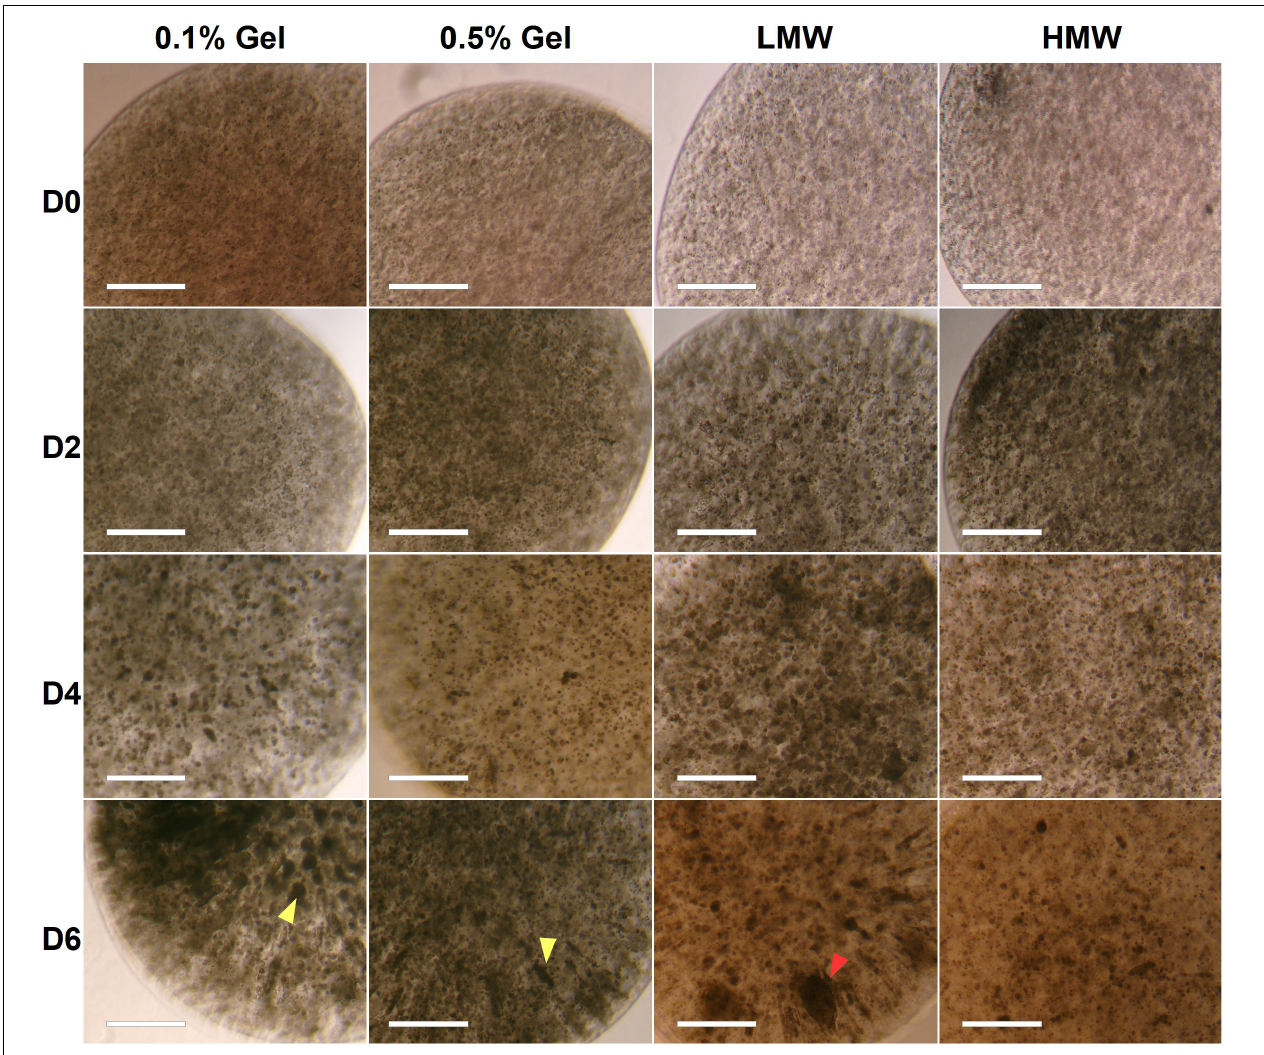
FIGURE 3 | Brightfield images of aggregate formation by encapsulated ESCs in high and low molecular weight alginate (HMW and LMW, respectively) mixed with 0.1 and 0.5% gelatin. Although some aggregates in LMW were very large ( ∼ 300 µ m, red arrowhead), these were infrequent and the majority of beads contained smaller circular and tubular aggregates ( ∼ 100 µ m). Scale Bar: 500 µ